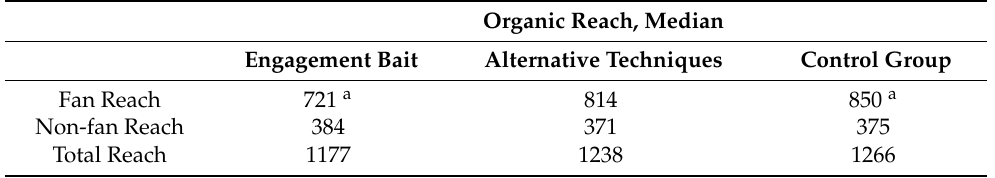
Table 1. The median of fan, non-fan, and total organic reach of engagement bait, alternative tech- niques, and the control group. Organic Reach, Median Engagement Bait Alternative Techniques Control Group Fan Reach 721 a 814 850 a Non-fan Reach 384 371 375 Total Reach